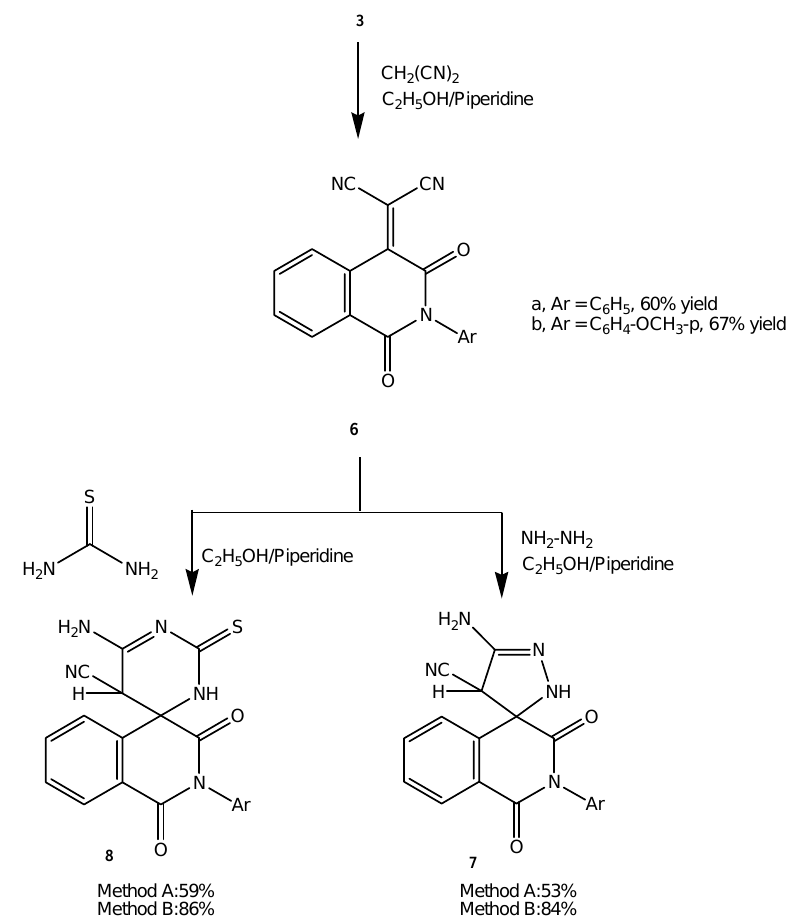
Scheme 2. Reactions of isoquinolinylidenemalononitriles with hydrazine hydrate and thiourea; synthesis of 7 and